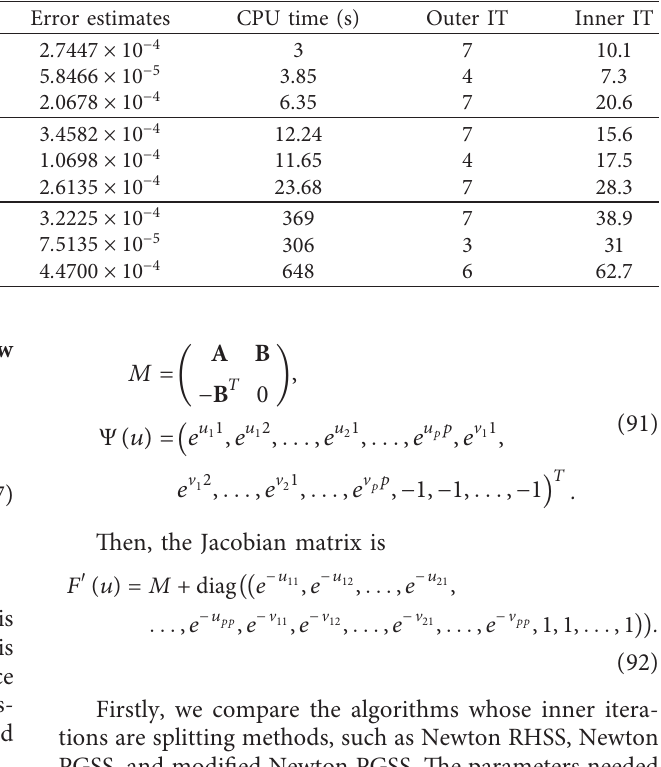
Table 5: Numerical results of inexact methods for v � 0.1 and η �